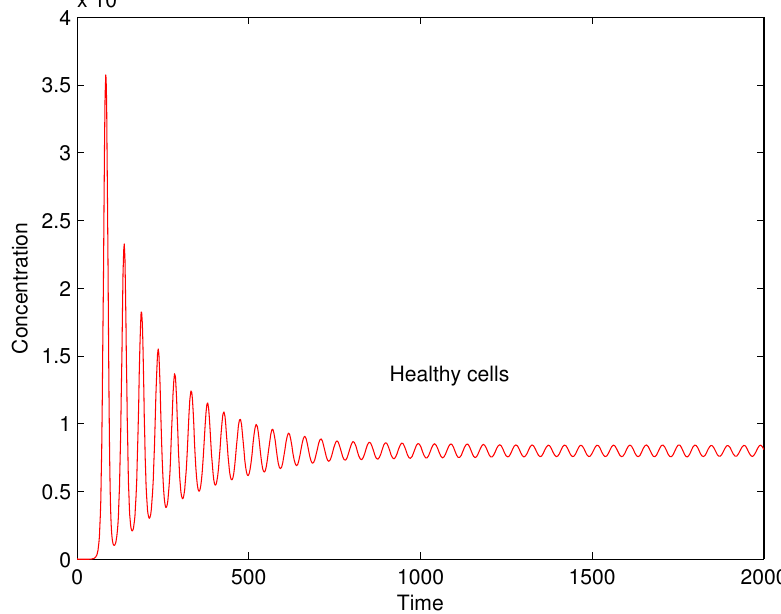
Figure 5. Concentrations of healthy cells for p id =